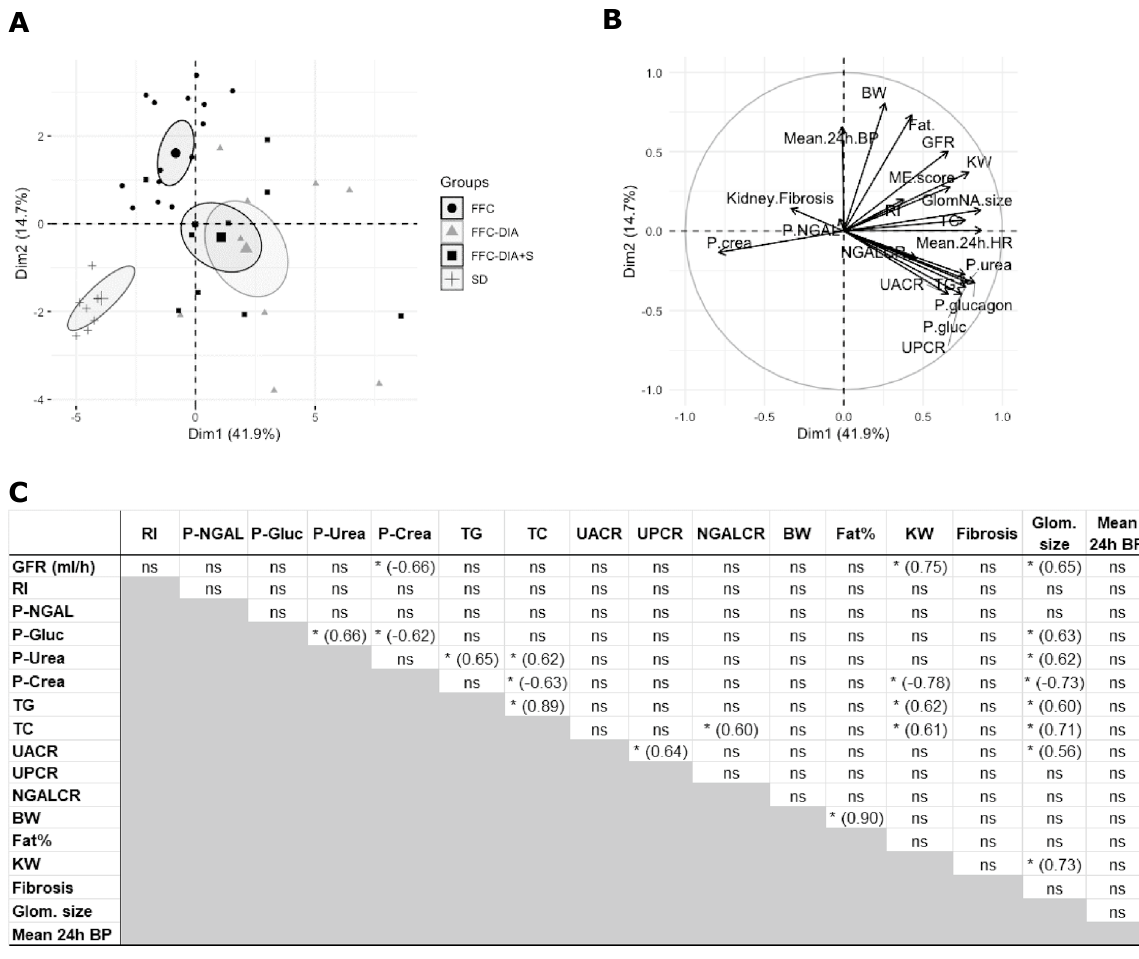
Figure 3. PCA plot ( A ), PCA variable correlation plot ( B ), and Spearman correlation analysis ( C ). *p < 0.05, number in parenthesis is the Spearman correlation coefficient for significant correlations. RI: resistive index, p-NGAL: plasma neutrophil gelatinase-associated lipocalin, p-Glu: plasma glucose, P-crea: plasma creatinine, TG: triglycerides, TC: total cholesterol, GFR: glomerular filtration rate, UACR: urinary albumin to creatinine ratio, UPCR: urinary protein:creatinine ratio, NGALCR: urinary neutrophil gelatinase-associated lipocalin to creatinine ratio, Fat%: body fat percentage, KW: Kidney weight, Glom. Size: glomerular size, BP: blood pressure, HR: heart rate.